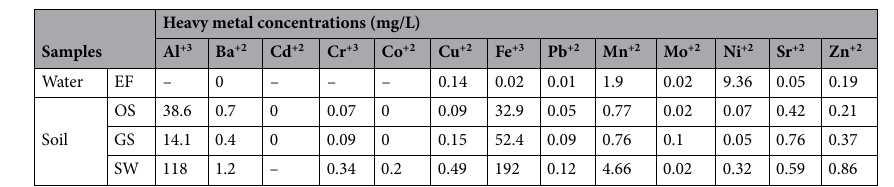
Table 1. Analysis of heavy metals with ICP (mg/L) in collected samples. Sb +3 , As +3 , Se −2 , Sn +2 , V +2 , and Hg +2 were not detected. EF Electrical factory, OS Oil and soap company, GS Gas station, and SW Soil near sewage water. – , Not detected.